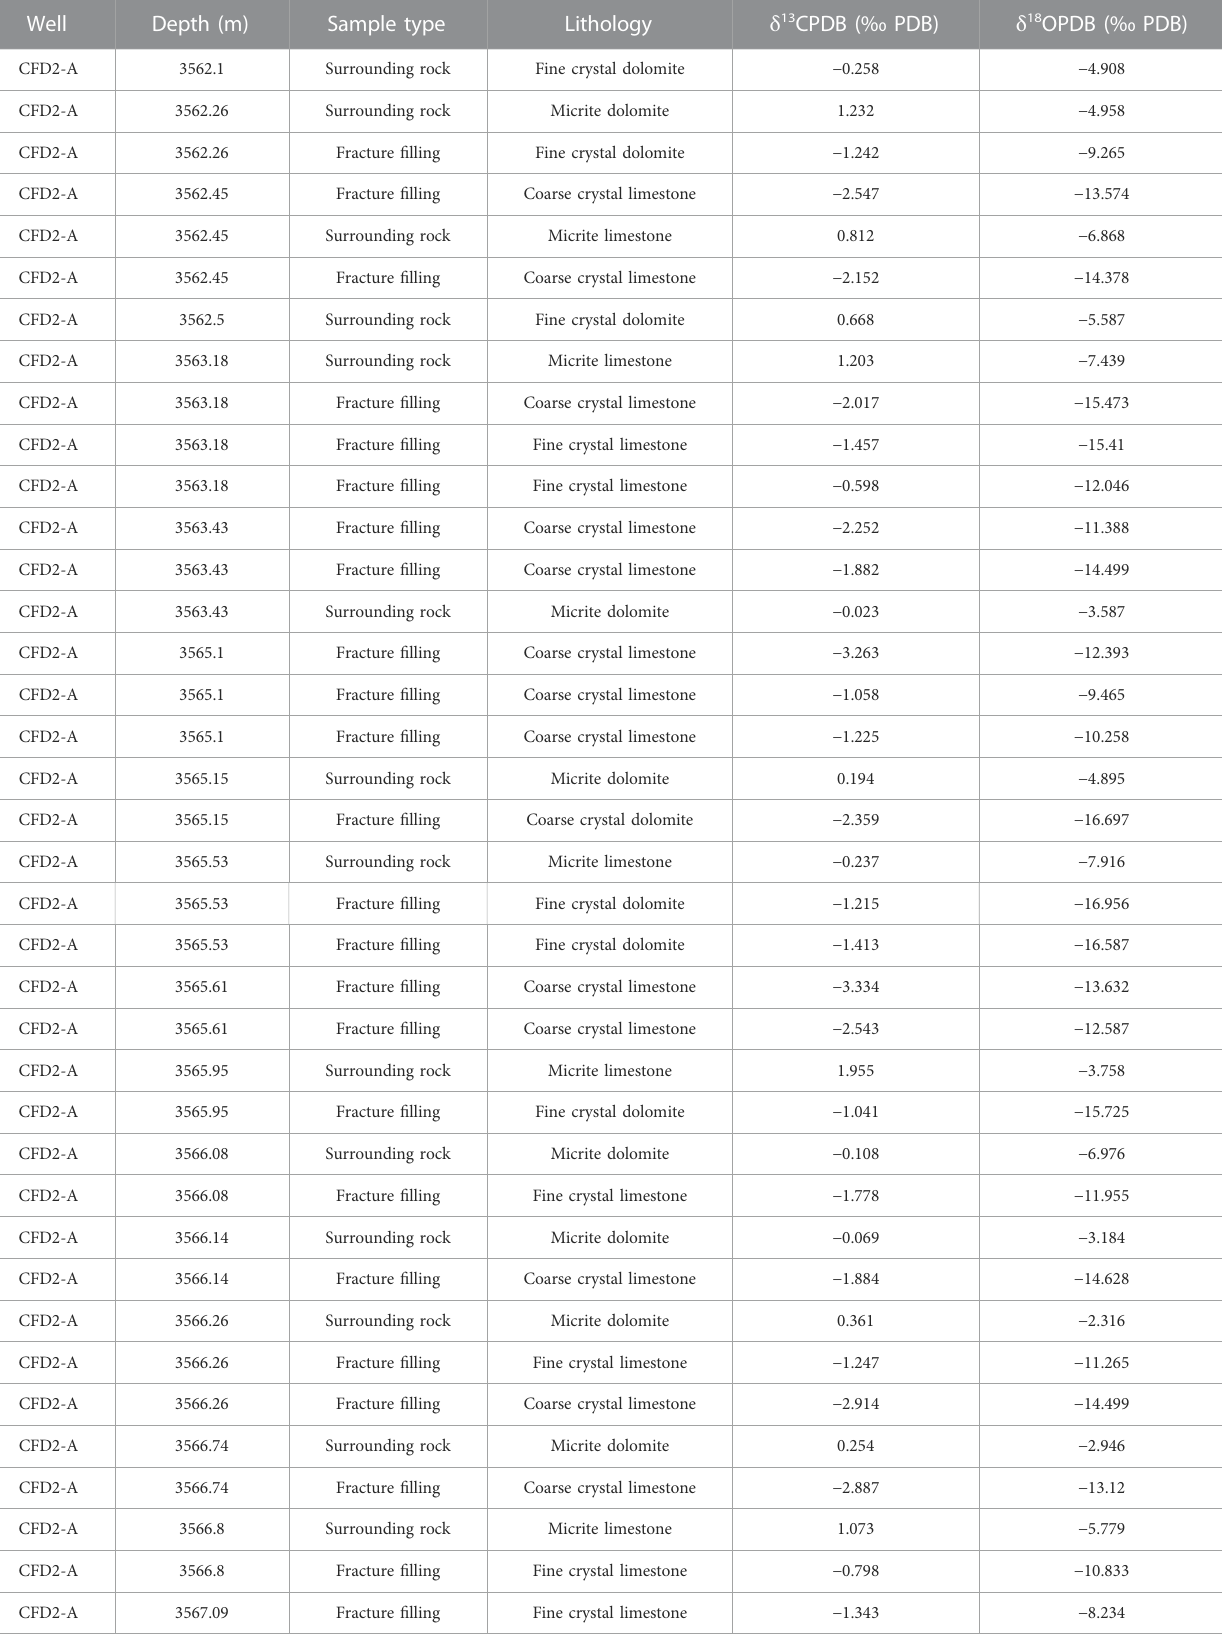
TABLE 1 Characteristics of C and O isotopes of surrounding rocks and fracture fi llings in the CFD